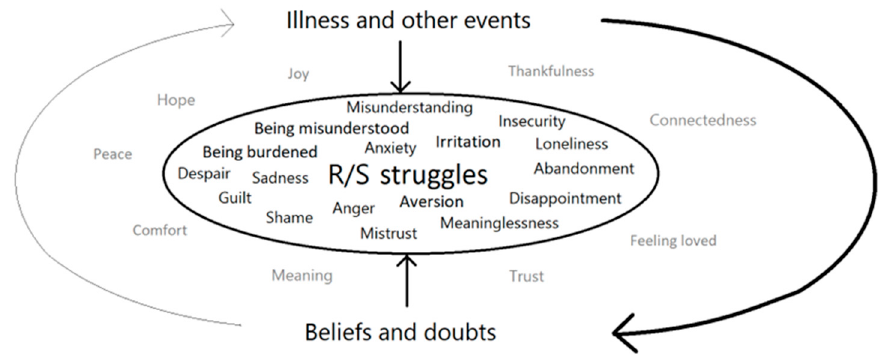
Figure 2 . Patients’ experienced place of R/S struggles (S) in relation to illness (I). Figure 2. Patients’ experienced place of R/S struggles (S) in relation to illness